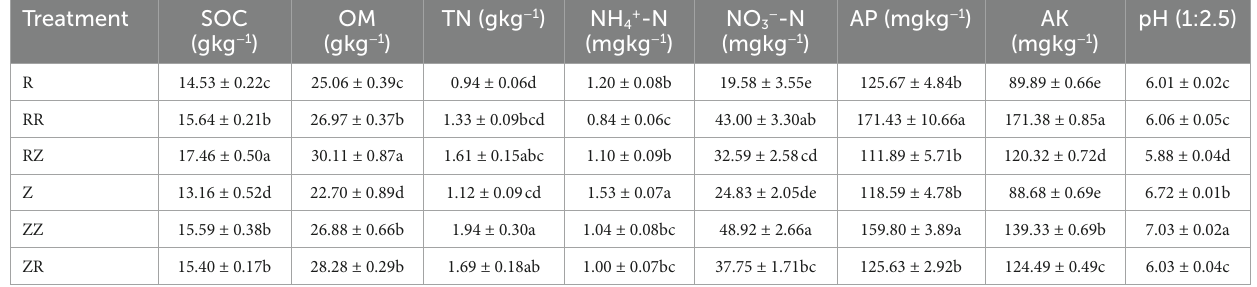
TABLE 2 Soil characteristics of different treatments with straw.